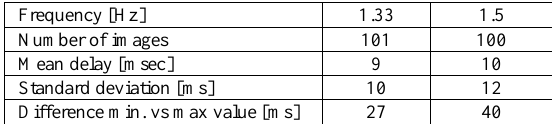
Table 8. Results of time delay